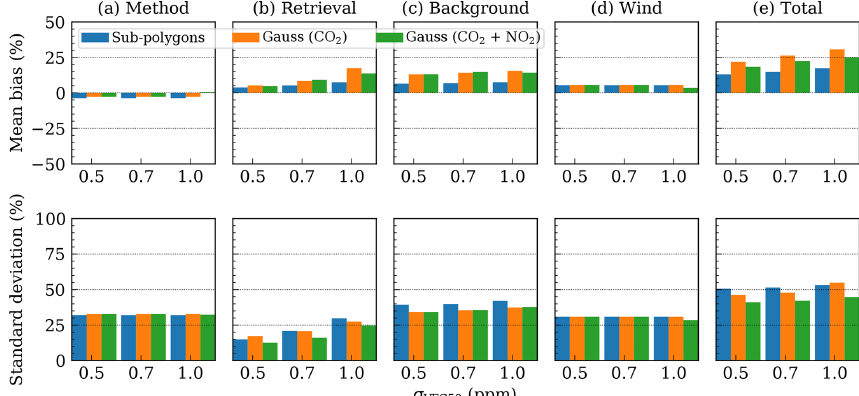
Figure 9. Same as Fig. 8 but for plumes detected from NO 2